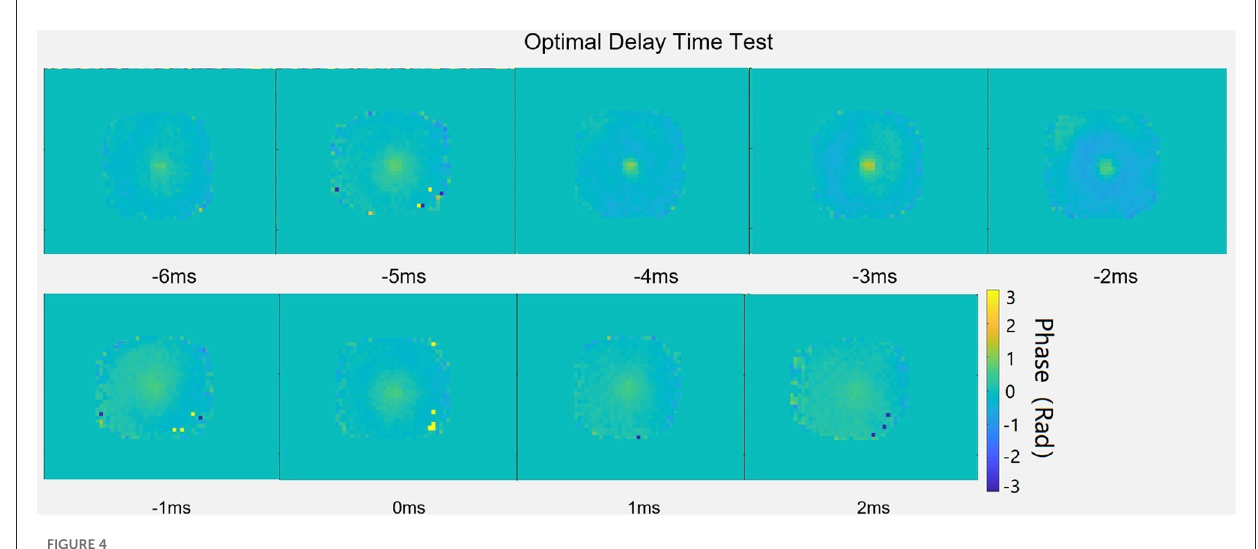
FIGURE4 Effect of delay time (t delay ) on phase contrast maps in an agar phantom.